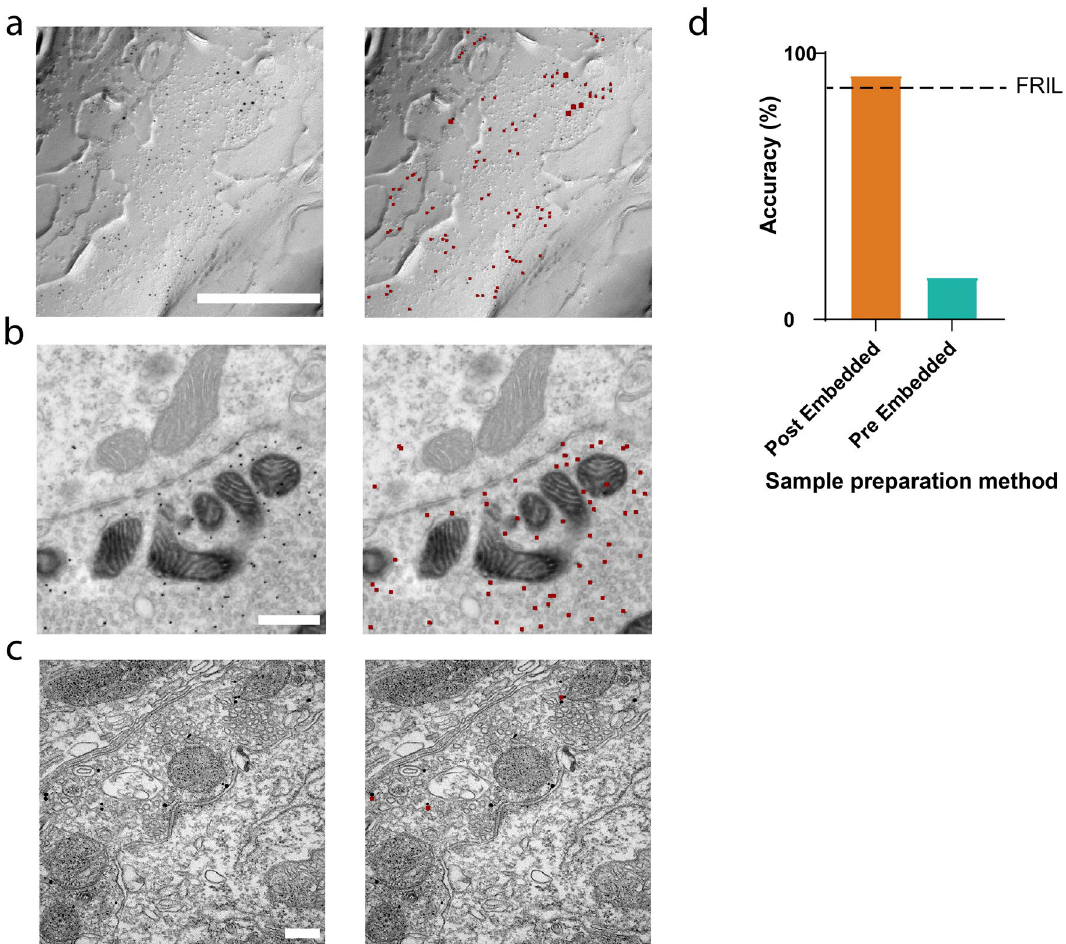
Figure 5. Generalizing to other EM techniques. Left: Sample input images. Right: Sample Gold Digger output – dark red indicates annotated gold beads. ( a ) FRIL sample. Scale bar = 500 nm. ( b ) Post-embedding method sample. Scale bar = 500 nm. ( c ) Pre-embedding method sample scale bar = 200 nm. ( d ) Comparison of labeling accuracy to FRIL method. FRIL images were collected from cerebellar tissue expressing Td-tomato-tagged channelrhodopsin2, and labeled with antibody-conjugated gold nanoparticles. Post-embedded samples = 4, pre- embedded samples =